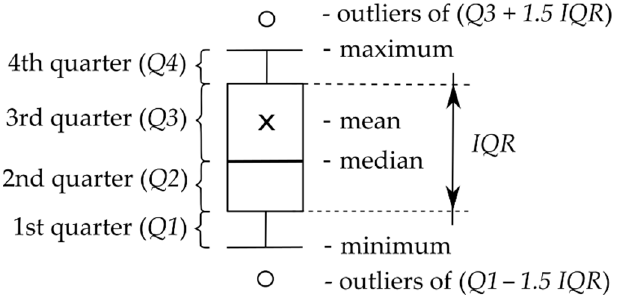
Figure 1. The visual notation of the box-and-whisker chart.